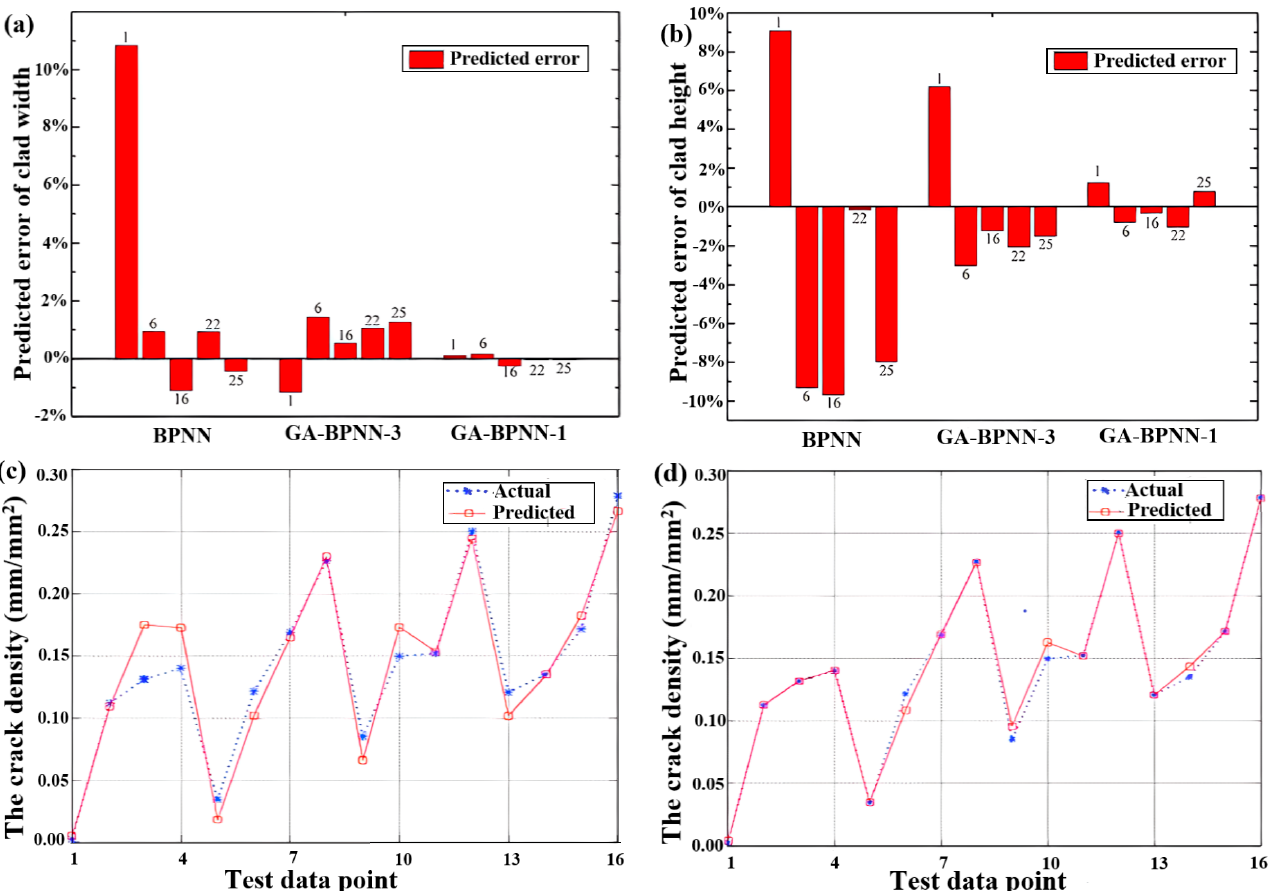
Figure 7. The GABP predictions and their comparison with the BPNN predictions. ( a ) Comparison of the prediction error of the triple-output-layer GABPNN with the single-output-layer GABPNN and BPNN for the clad width. Reprinted with permission from Ref. [126]. 2018, Springer Nature. ( b ) Comparison of the prediction error of the triple-output-layer GABPNN with the single-output-layer GABPNN and BPNN for the clad height. Reprinted with permission from Ref. [126]. 2018, Springer Nature. ( c ) Prediction results of BPNN [128]. ( d ) Prediction results of GABP [128].